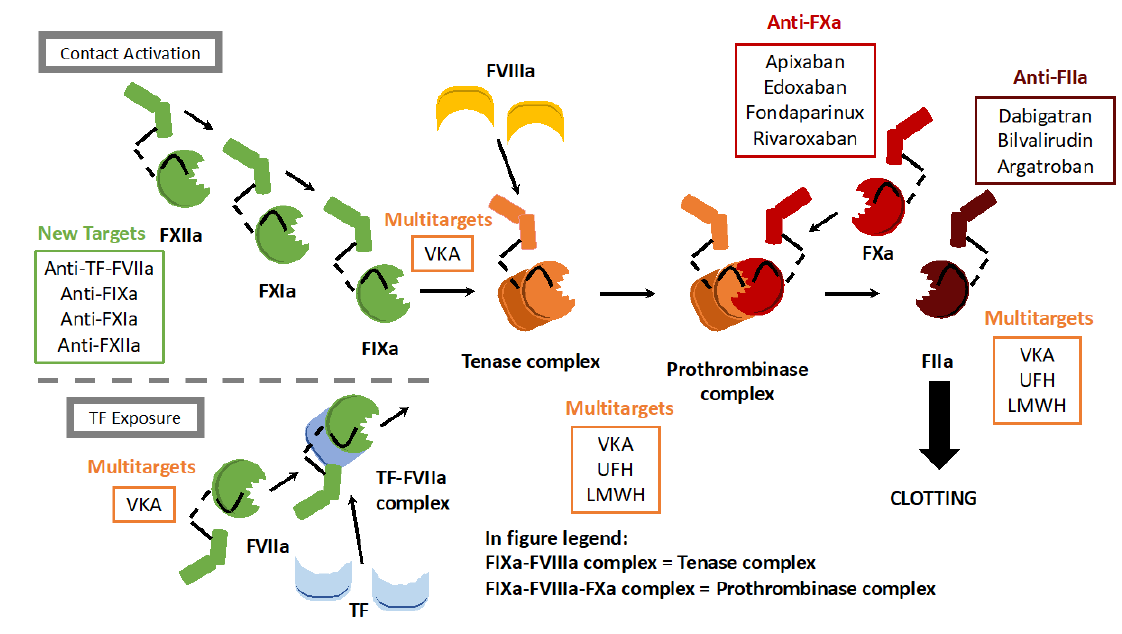
Figure 1. Anticoagulants and their targets within the coagulation cascade. The coagulation cascade consists of three parts: the tissue factor (TF) pathway, the contact activation pathway, and the common pathway. Currently used anticoagulants target primarily coagulation factors from the common pathway: FXa (apixaban, edoxaban, fondaparinux, and rivaroxaban) and thrombin (FIIa; dabigatran, bilvalirudin, and argatroban). UFH, VKA, and LMWH have multiple targets within the coagulation cascade. Anticoagulants that are currently under development or undergoing clinical trials target factors from the TF pathway (TF-FVIIa complex) or the contact activation pathway (FIXa, FXIa, and FXIIa). Tenase complex: FVIIIa-FIXa complex. Prothrombinase complex: FVIIIa-FIXa-FXa